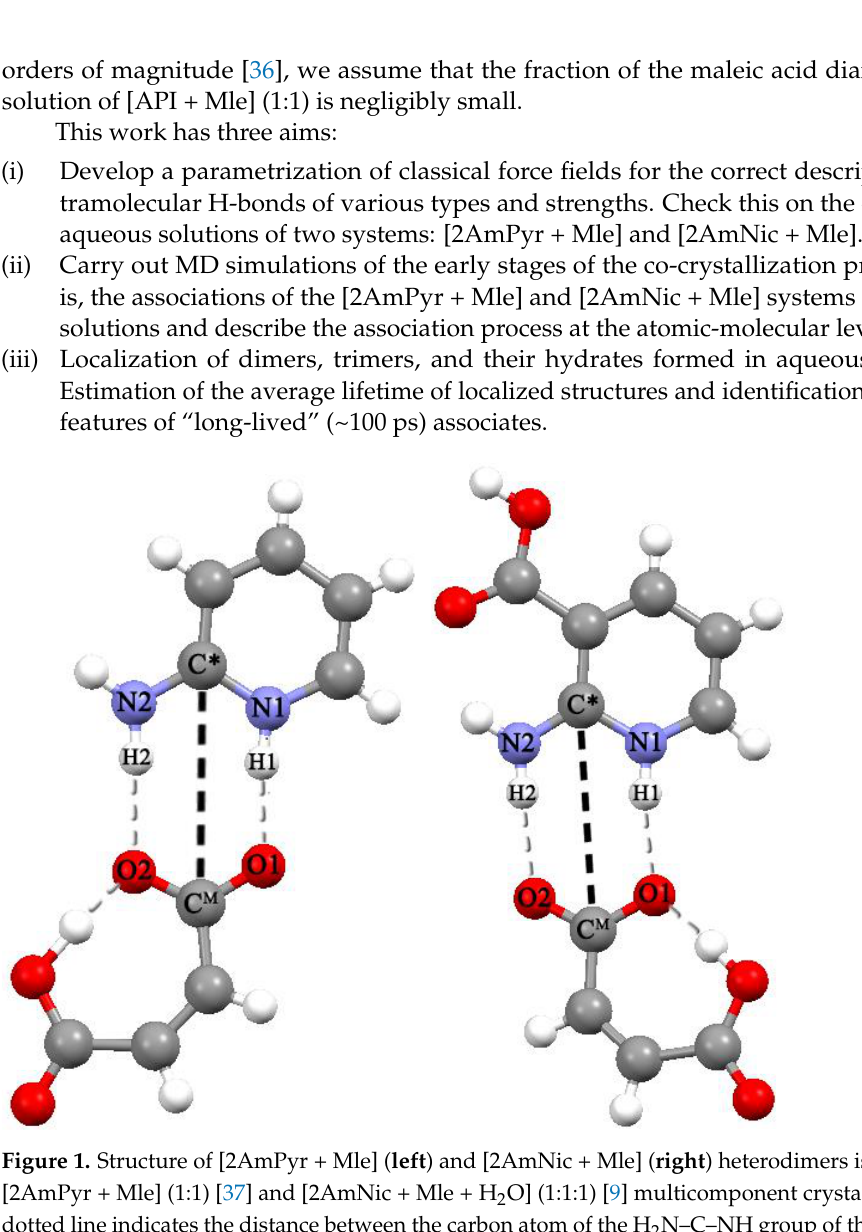
Figure 1. Structure of [2AmPyr + Mle] ( left ) and [2AmNic + Mle] ( right ) heterodimers isolated from [2AmPyr + Mle] (1:1) [37] and [2AmNic + Mle + H 2 O] (1:1:1) [9] multicomponent crystals. The black dotted line indicates the distance between the carbon atom of the H 2 N–C–NH group of the API cation and the carbon atom of the CO 2 − group of the maleic acid monoanion, R [(C* ··· C M ]. Gray dashed lines denote inter- and intramolecular H-bonds.